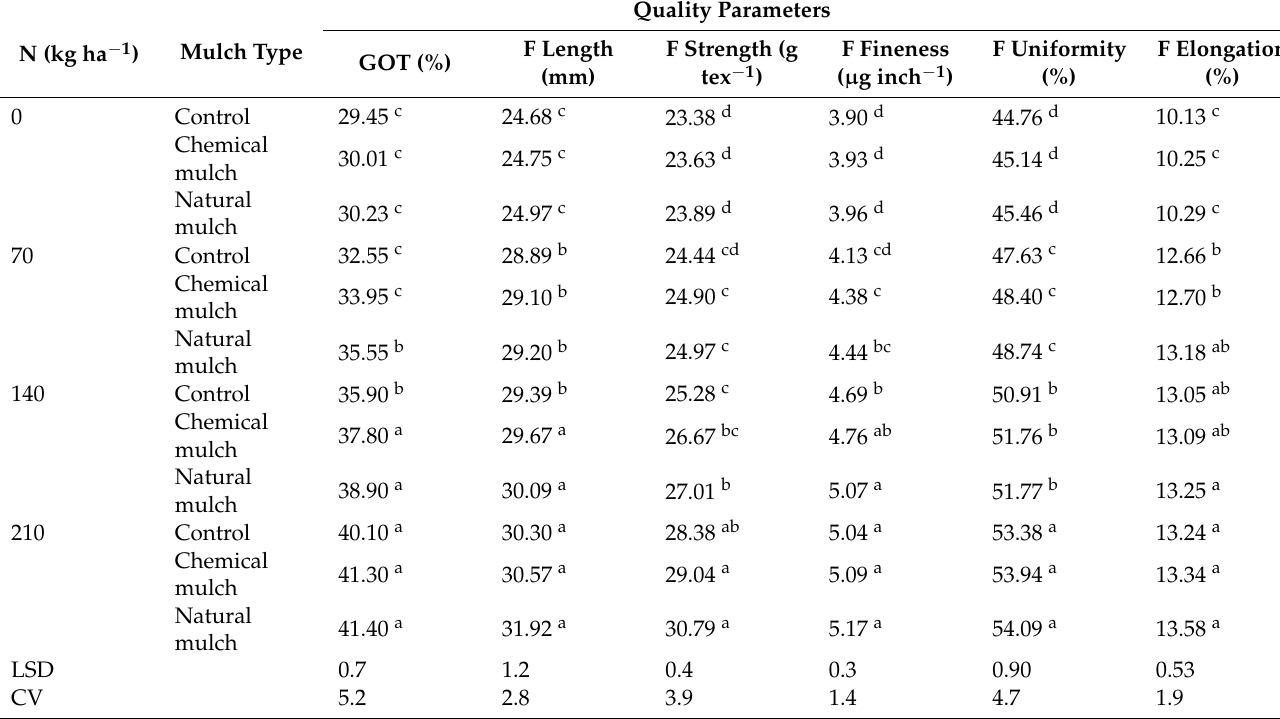
Table 2. Effects of nitrogen fertilization with mulch application on quality parameters of cotton during